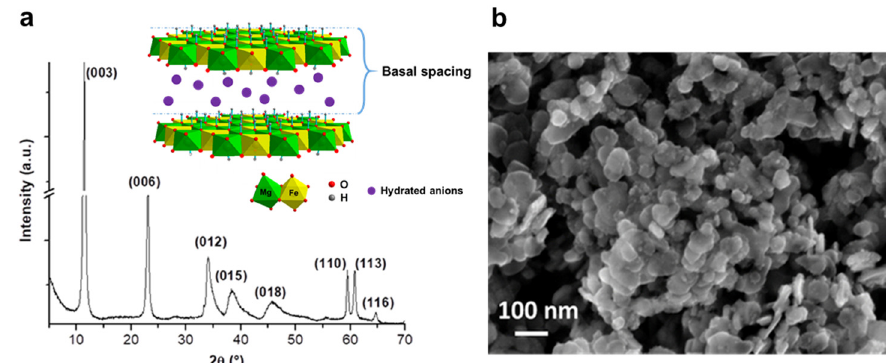
Figure 1. ( a ) X-ray powder diffraction pattern of the nano-Mg/Fe-layered double hydroxide (LDH) and structure of the Mg/Fe LDH, ( b ) SEM micrograph of the Mg/Fe-LDH coated gold electrode. S = 0.2 cm 2 .